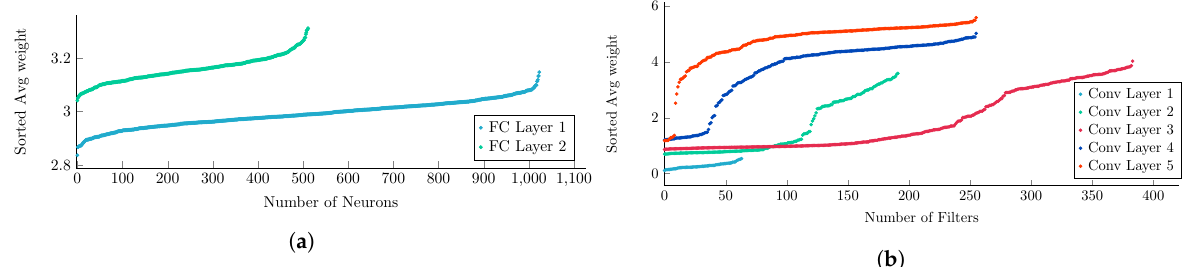
Figure 5. Analysis of sorted weights for FC and convolutional layers from AE and AlexNet model respectively. ( a ) Sorted Avg weights from two FC layers of AE model; ( b ) Sorted Avg weights from five convolutional layers of AlexNet